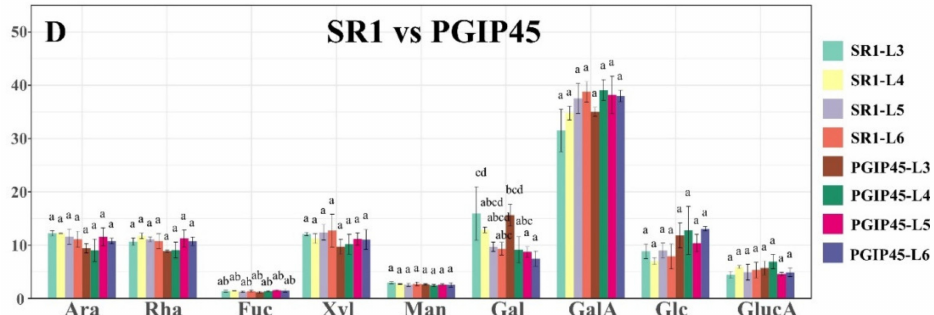
Figure 3. Monosaccharide composition of the cell wall, expressed in mol%, from the total alcohol insoluble residue (AIR) extraction of leaves from different tobacco lines. ( A ): Wild type SR1 versus CAD32. ( B ): SR1 versus CAD42. ( C ): SR1 versus PGIP37. ( D ): SR1 versus PGIP45. Ara: arabinose; Rha: rhamnose; Fuc: fucose; Xyl: xylose; Man: mannose; Gal: galactose; GalA: galacturonic acid; Glc: glucose; GlcA: glucuronic acid; L: leaf. The bars represent the average of three biological repeats. A